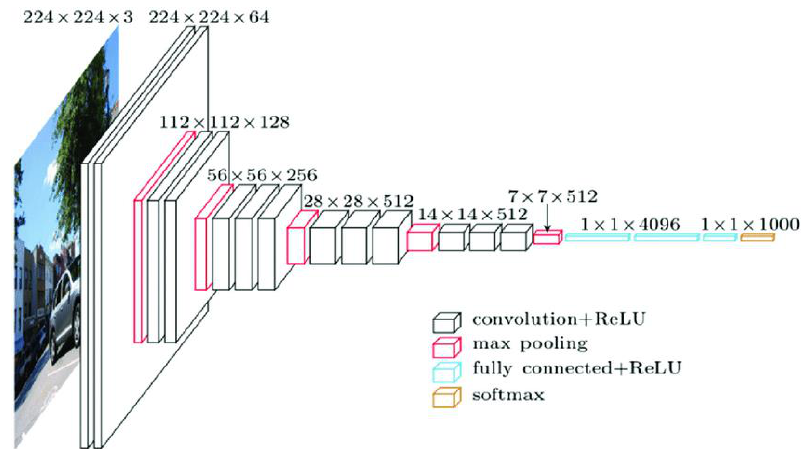
Figure 5. Architecture of VGG-16.